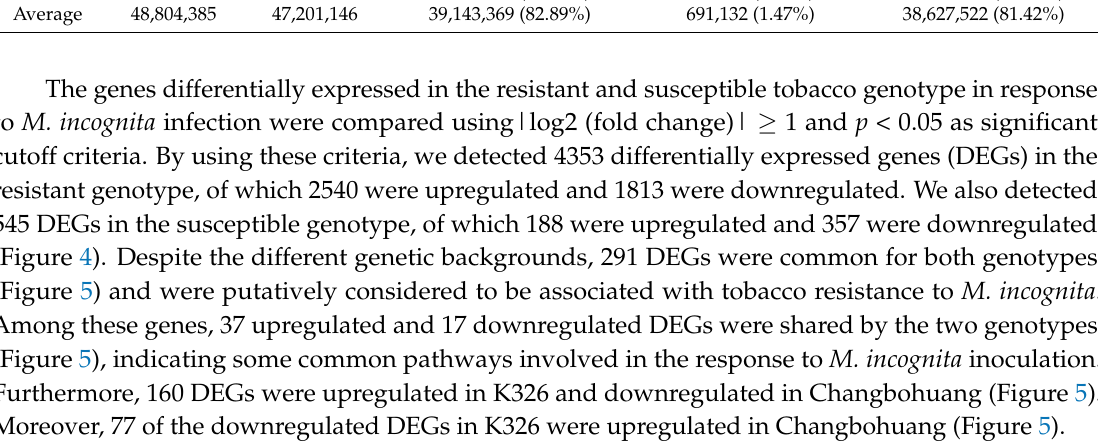
Table 1. Statistical analysis of transcriptome data in the resistant (R) and susceptible (S) genotype. Treatment